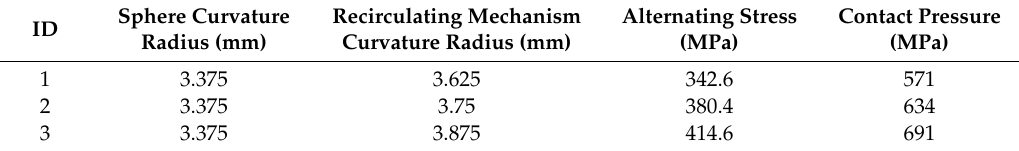
Table 4. The alternating stress and contact pressure for the considered curvature radii with a contact force equal to 120 N.